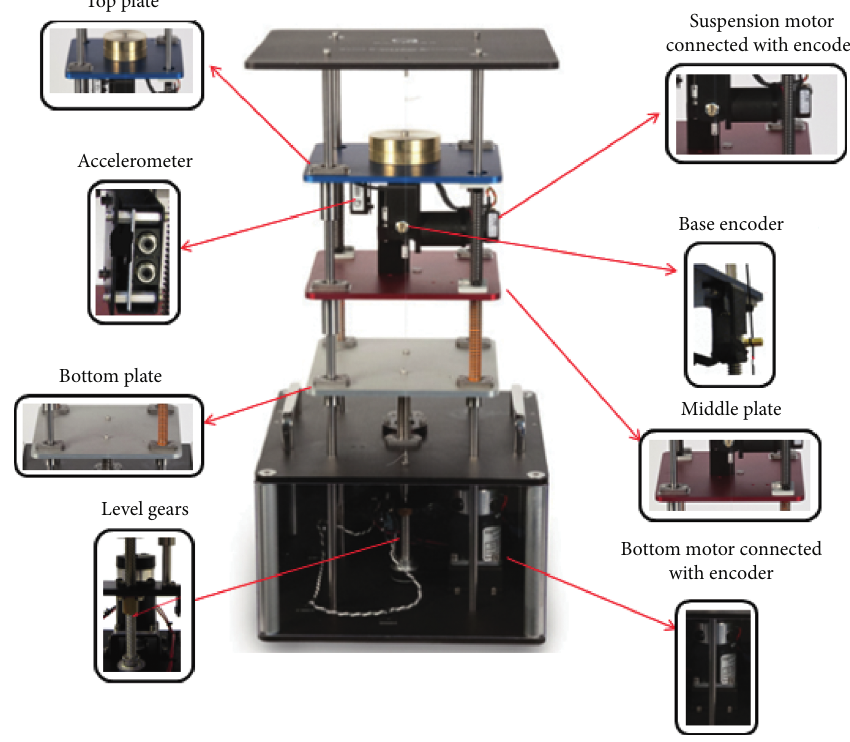
Figure 6: Quarter-car ASS workstation.